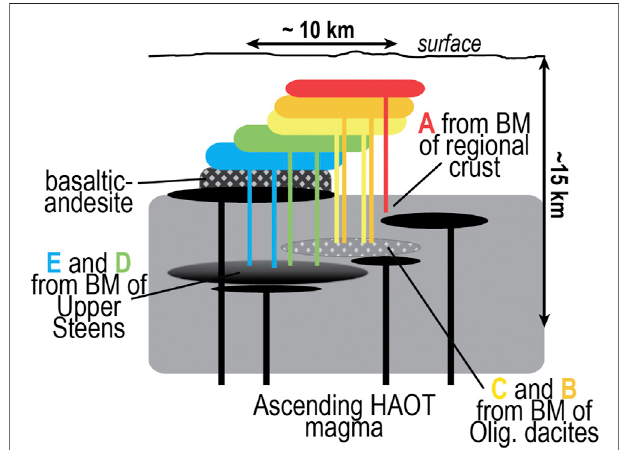
FIGURE15 | A magma con fi guration model togenerate the Rattlesnake Tuff (RST) high-silica rhyolite (HSR) Groups where each HSR magma is generated independently from one another, based on potential batch melting orcrystalfractionationsources.Inthisscenario,GroupEandDmagmas come from batch melting of Upper Steens Basalts, Group C and B magmas come from batch melting of Oligocene dacites, and Group A magma comes from batch melting of felsic regional crust. Density differences would be great enough to allow one more evolved, higher-silica magma to buoyantly ascend through a less evolved, lower-silica magma. Density differences allow these HSRmagmastoresidejuxtaposedtooneanotherinthecrustandcontinueto fractionate without mixing between layers, and compositional boundaries are disturbed during